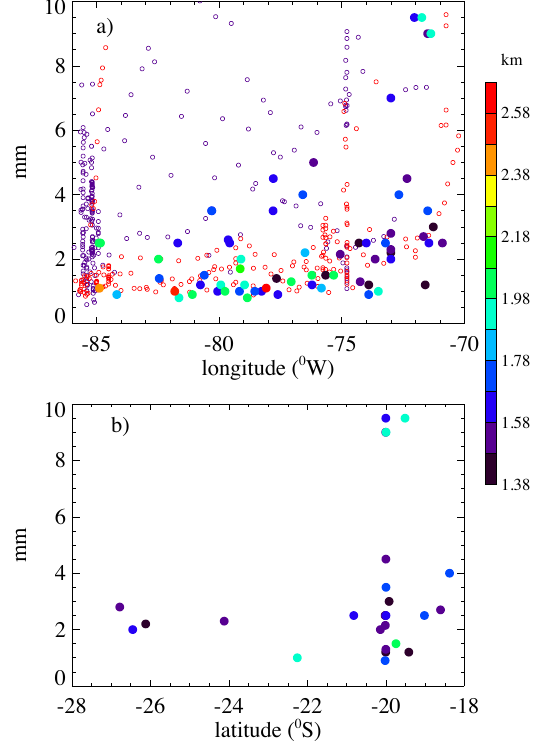
Fig. 11. Free-tropospheric water vapor paths retrieved from the above-cloud legs (a) of all research flights, as a function of lon- gitude (85 legs), and (b) as a function of latitude for longitudes east of 75.5 ◦ W (42 legs). Colors indicate the leg altitude. Mean flight altitudes, when binned by 2.5 ◦ in longitude from 70 ◦ W west- ward, were, in meters, with the number of samples in parentheses: 1495 (14), 1370 (26), 1715 (10), 1695 (19), 1735 (11), and 1855 (5). These altitudes were used to calculate free-tropospheric WVP values from soundings launched from ship during VOCALS (dark orange, N = 207) and cruises during 2001, 2003, 2006 and 2007 (purple, N =